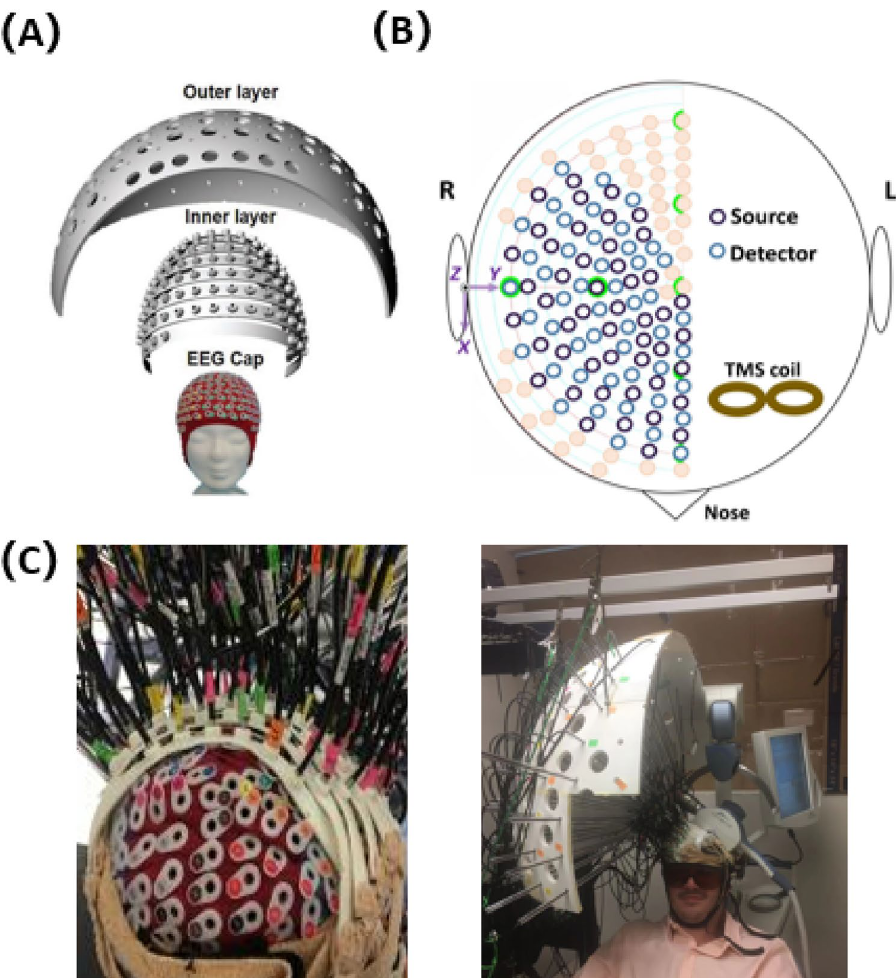
Figure 1. Custom DOT head interface. ( A ) Two layer design with an inner and outer layer superimposed upon a modified electroencephalogram cap; ( B ) top-down schematic depicting the location of the TMS coil (light brown figure of eight symbol) over the left dorsolateral prefrontal cortex and the DOT cap over the right hemisphere (centered upon the R DLPFC); ( C ) photographs of the interface connected to a human subject; the probe comprised of 48 source-detector pairs in